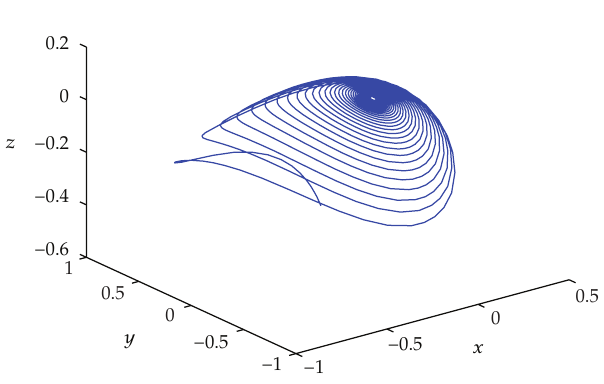
Figure 5: Phase diagram for system (cid:5) 2.2 (cid:6) with c (cid:7) − 1 .